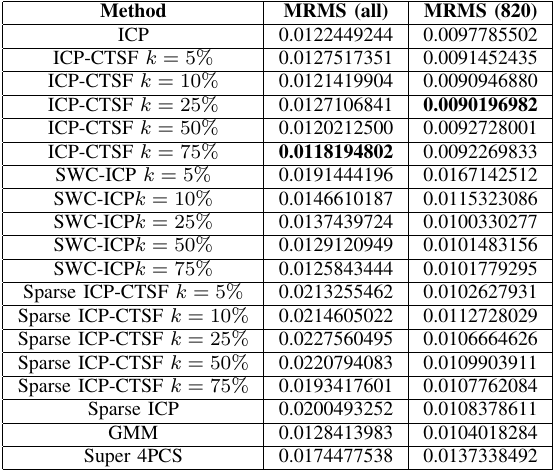
TABLE VIII: MRMS for frame-to-frame registration of video #03118 with ς = 1 and r = 8 . Second column gives the MRMS using the complete video and the third column using the first 820